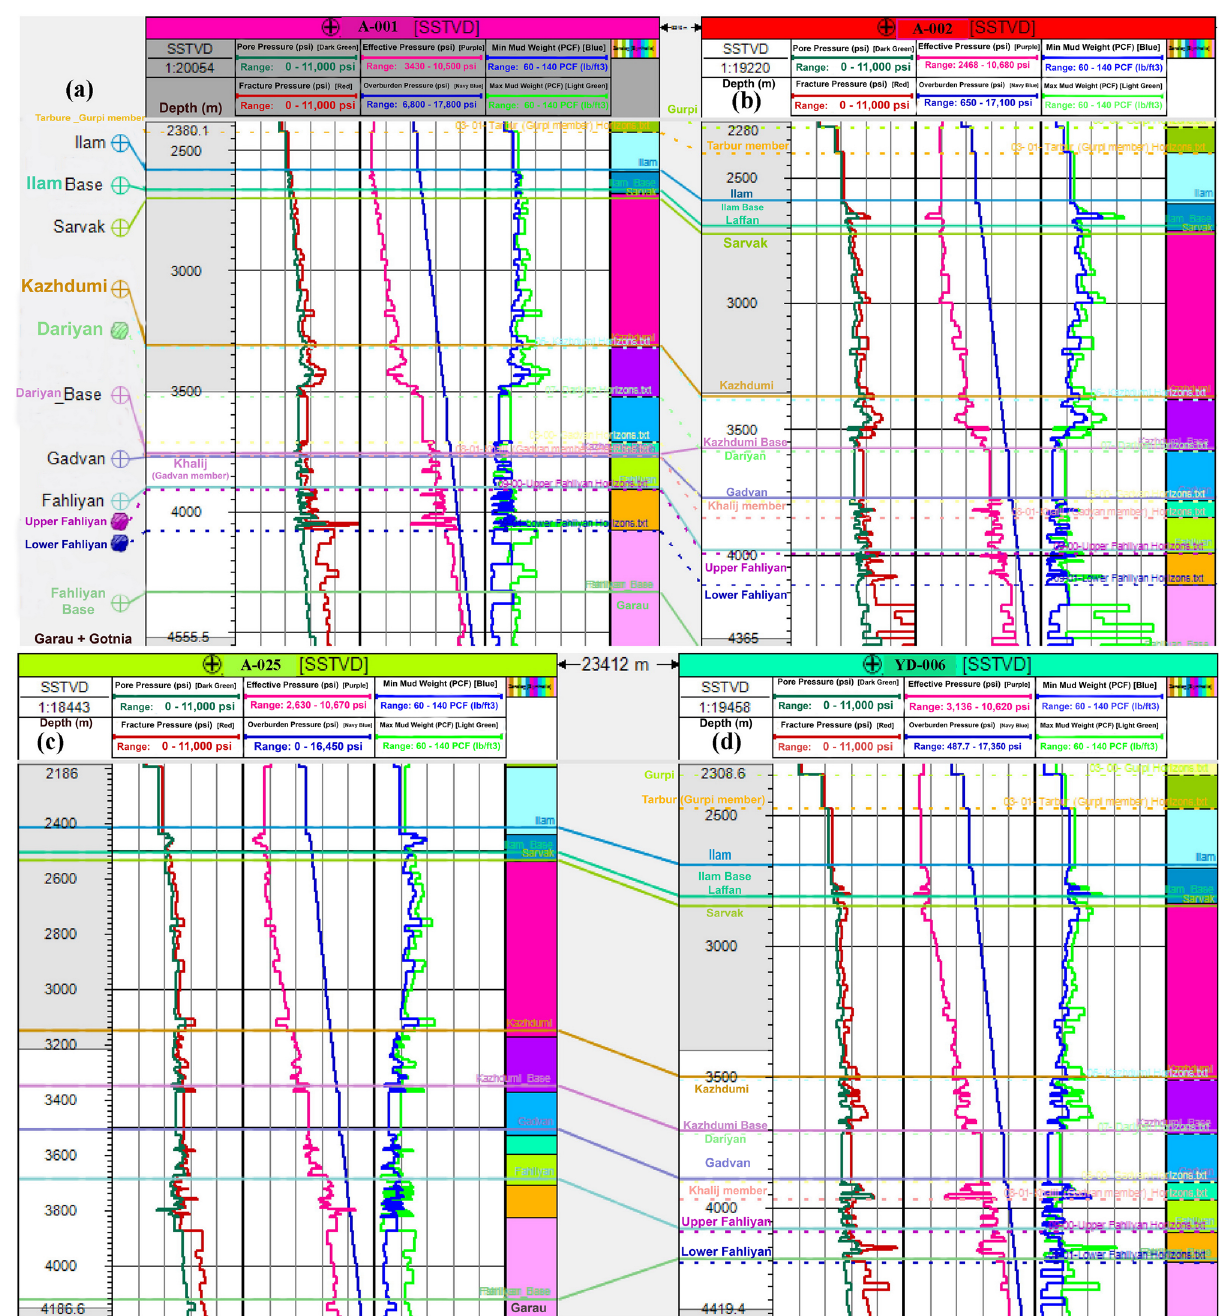
Fig. 15 Synthetic logs of changes in "pore pressure and fracture pressure," "effective pressure and overburden," and changes in "minimum and maximum mud weight" in a A-001, b A-002, c A-025, and d YD-006 exploratory